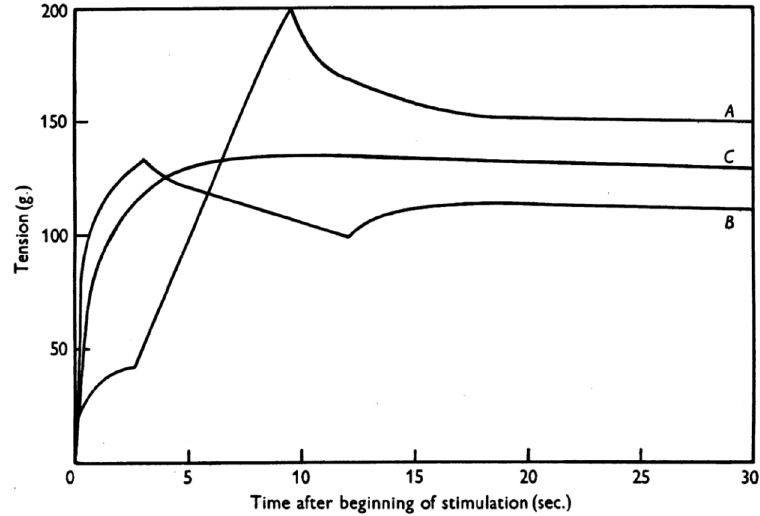
Figure 1. Residual force enhancement and residual force depression [5]. Force was measured in dogfish muscles. Note that the isometric steady-state force after stretch ( A ) and after shortening ( B ) were different compared to the force measured in a purely isometric contraction ( C ) although the final muscle length and contraction (stimulation) intensity were identical among A, B and C. (Reprinted with permission).